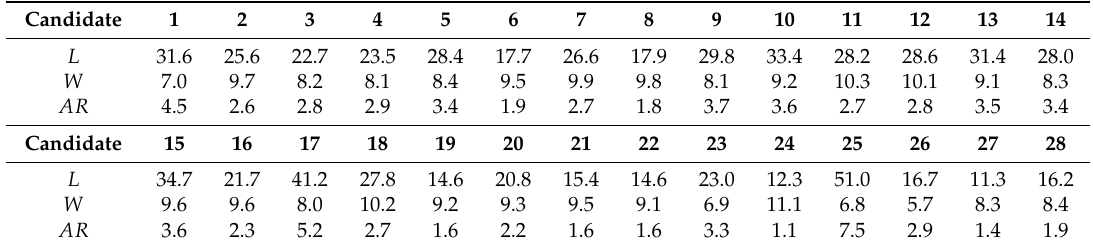
Table 5. L (length), W (width) and AR (aspect ratio) of targets for test image ID 1 ( L and W are measured in pixels).